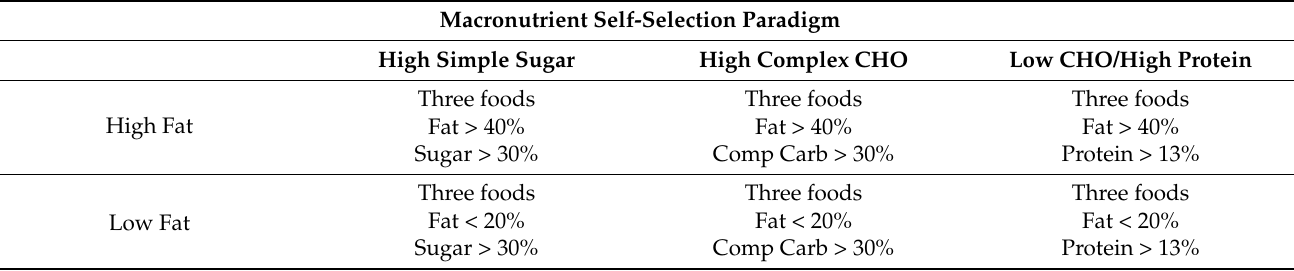
Table 1. Macronutrient self-selection paradigm.